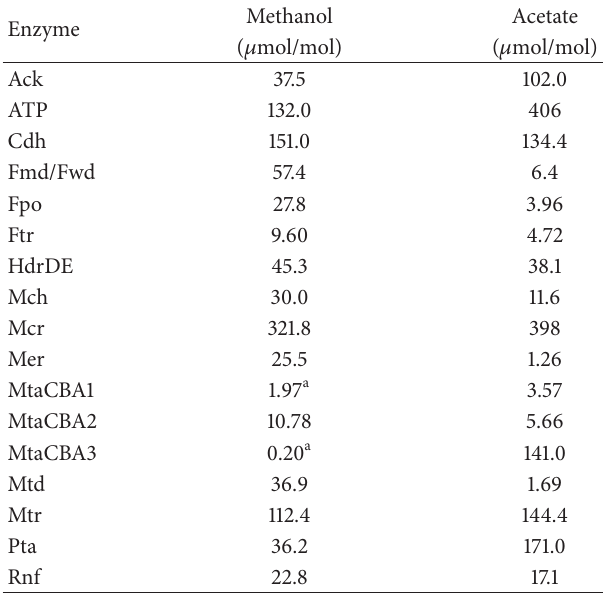
Table 2: A list of enzyme stoichiometries in the cell mass reaction. The moles of the indicated protein that are created from 1 mole of ATP calculated in Section